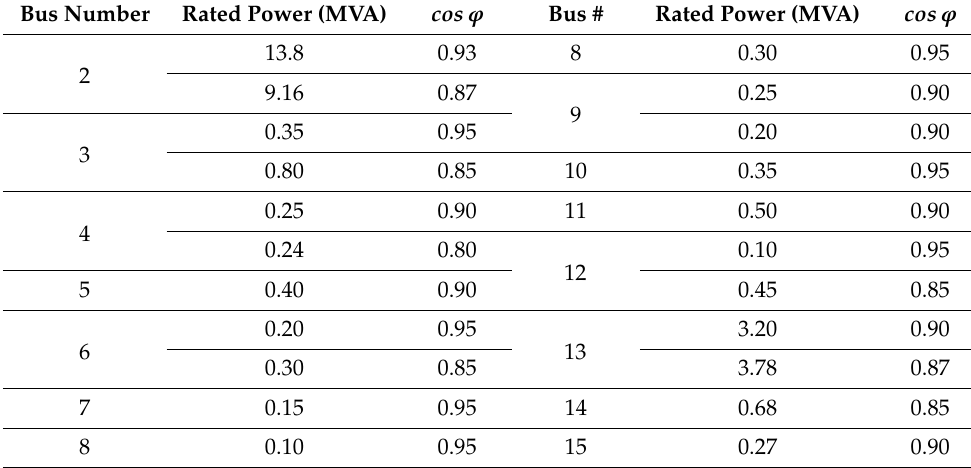
Table 1. Load Input data.